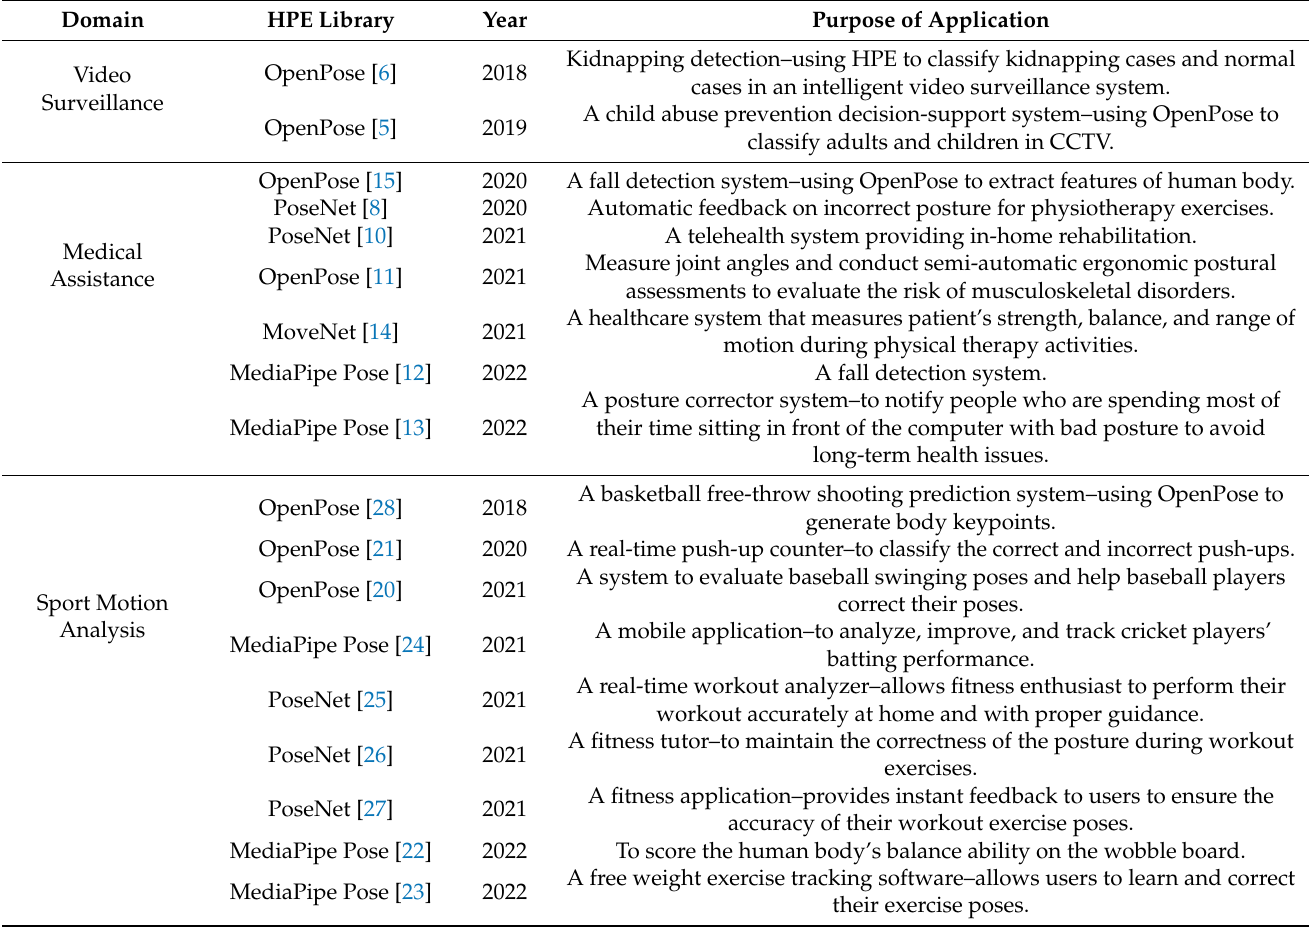
Table 1. Applications of PoseNet, MoveNet, OpenPose, and MediaPipe Pose in different